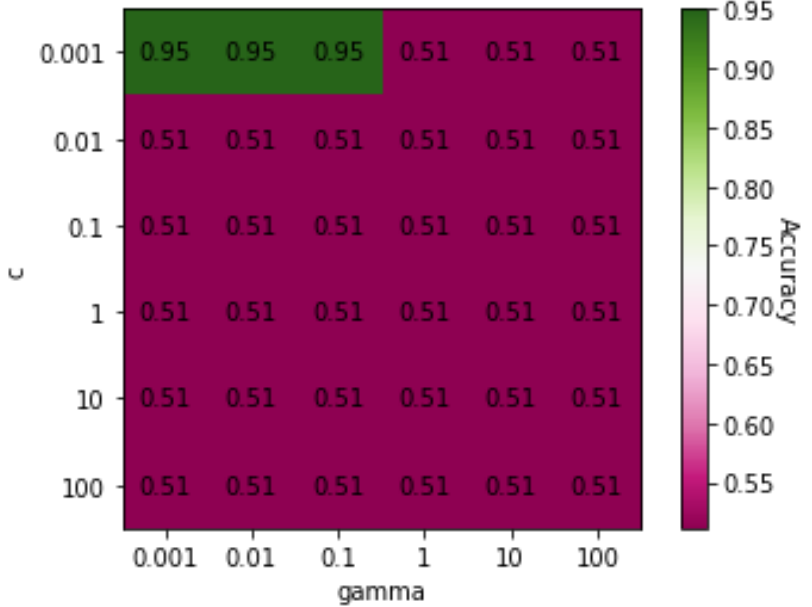
Figure 3. Heatmap of values of SVM parameters C and γ on Dataset 03.